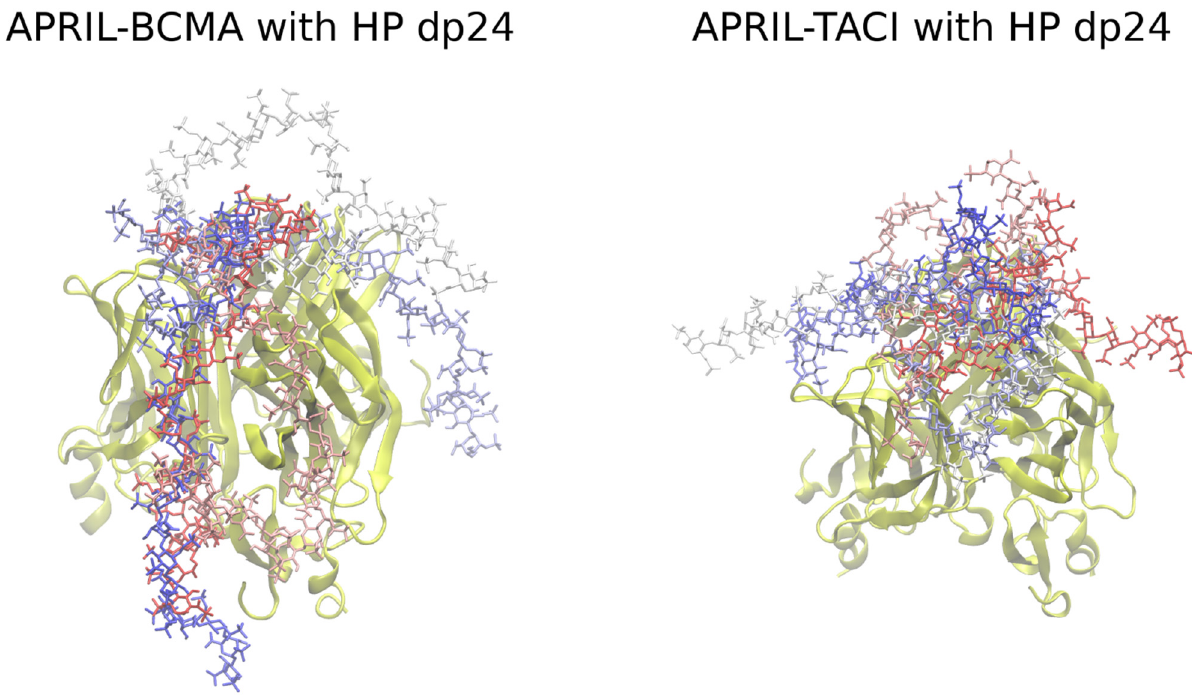
Figure 1. The five most energetically favorable structures of the APRIL–BCMA ( left ) and APRIL–TACI ( right ) complexes with heparin dp24, obtained by docking with Autodock3 (heparin in licorice representation, red-white-blue range of color; APRIL, BCMA, TACI in cartoon representation in yellow).